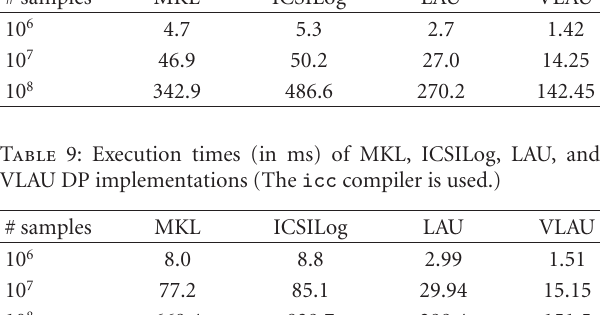
Table 11: Execution times (in ms) of MKL and ICSILog DP implementations compiled with icc and − O2/ − O3